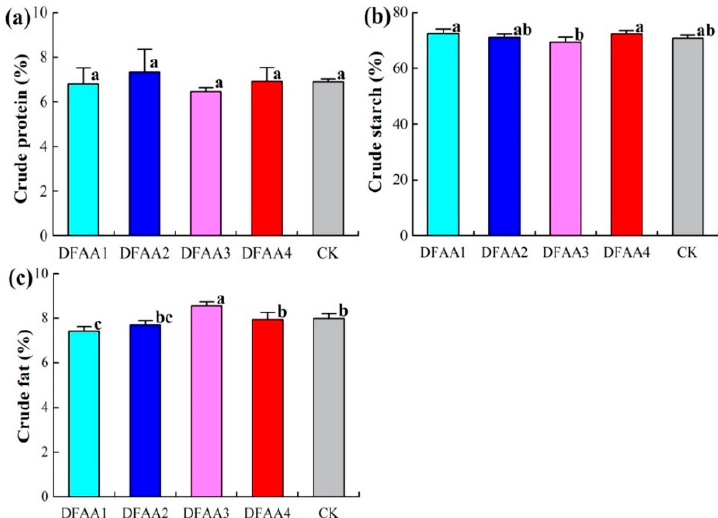
Figure 7. The parameters of summer maize grain quality at harvest. ( a ) crude protein; ( b ) crude starch; ( c ) crude fat. Error bars represent standard deviations ( n = 6), different letters indicate significant difference among the treatments at 0.05.